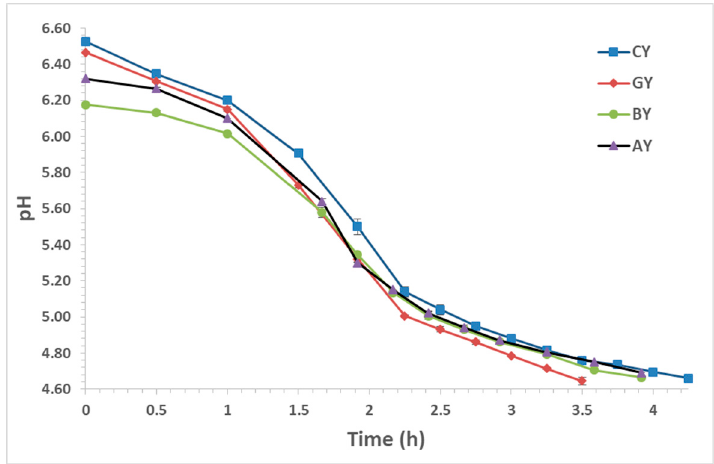
Figure 2. Acidification kinetics during yogurt production (CY = control yogurt; GY = yogurt with grape juice; BY = yogurt with blueberry juice; AY = yogurt with aronia juice).